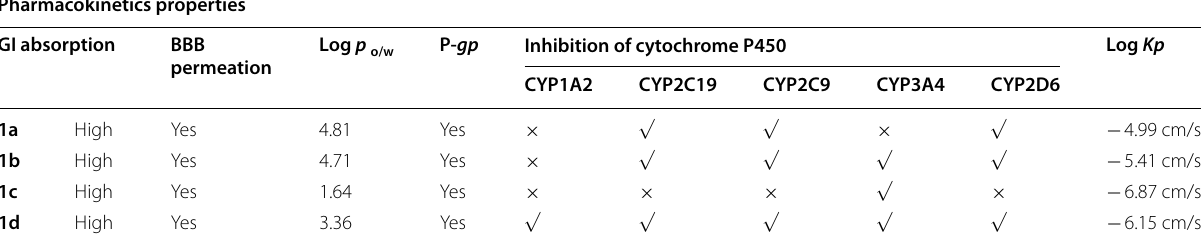
1a , gangetin; 1b , gangetinin;, 1c , desmocarpin; 1d , desmodin; GI, gastrointestinal absorption; BBB, blood–brain barrier permeability; Log P o/w , lipophilicity; P- gp , P-glycoprotein substrate; Log Kp , skin permeation